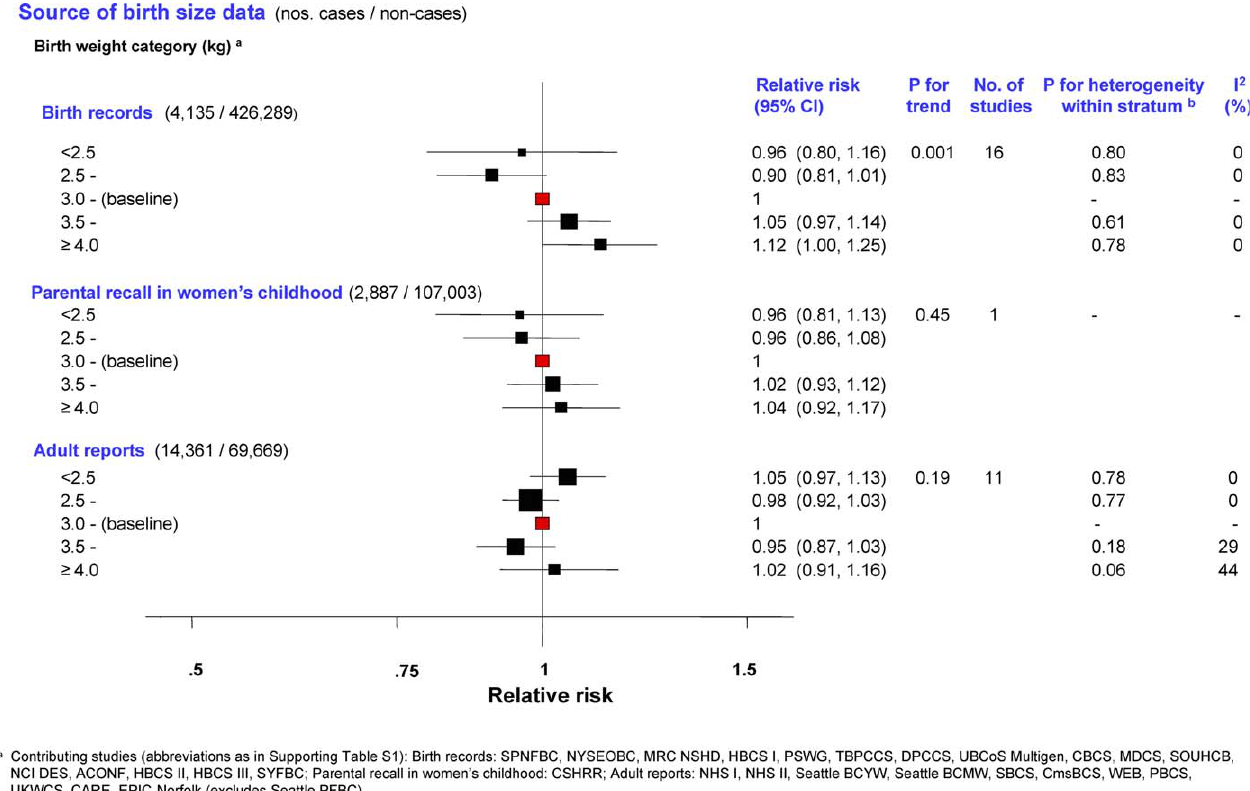
Figure 1. Minimally Adjusted Pooled Breast Cancer RRs Stratified by Source of Birth Size Data in Relation to Categorical Birth Weight (Singleton Studies Only) The area of the black squares is inversely proportional to the variance (on the log scale).